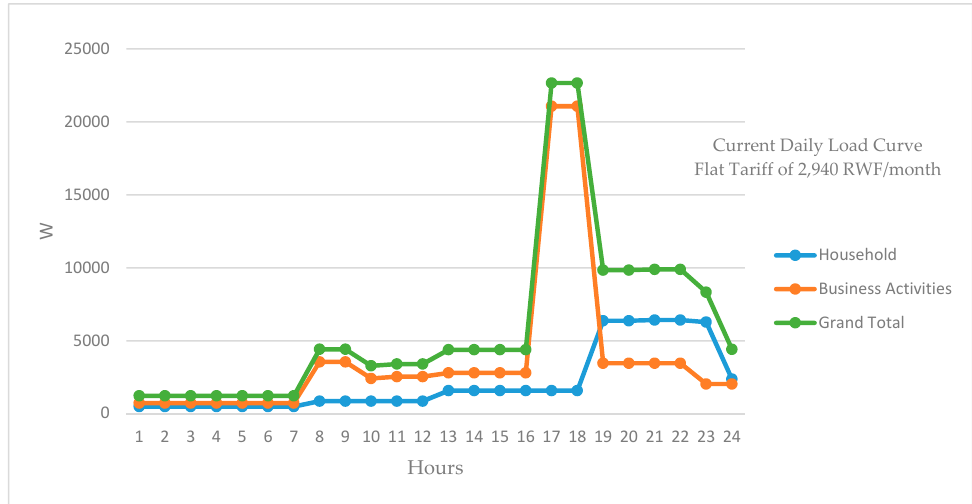
Figure 4. Current daily load curves.